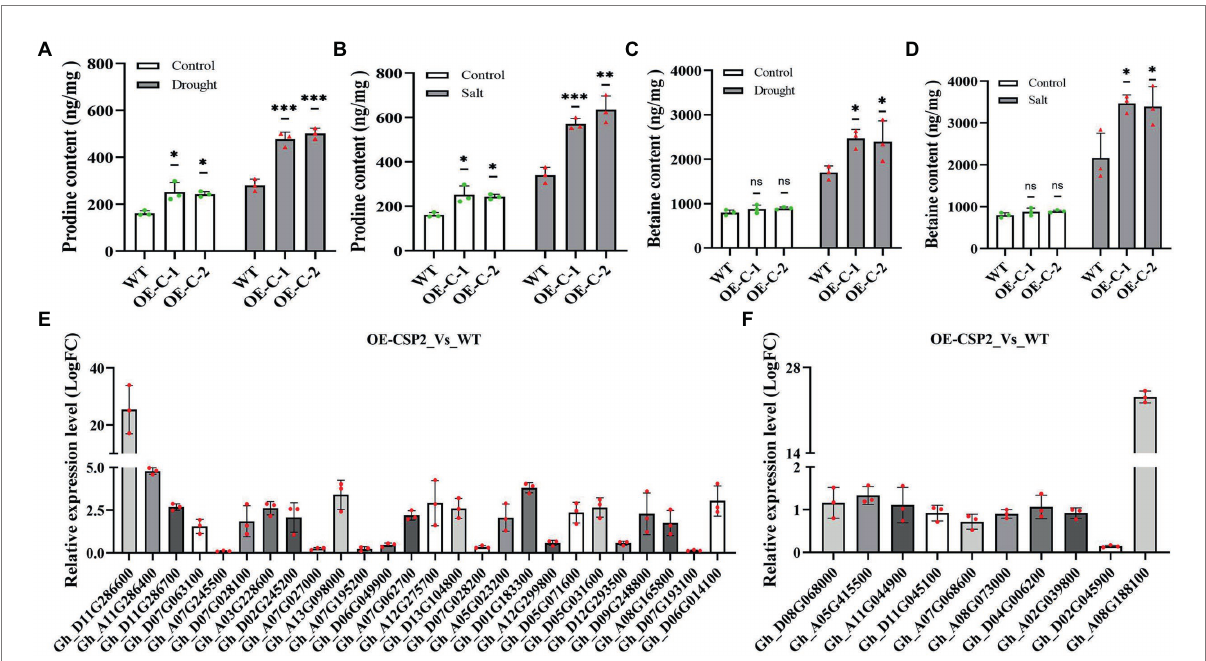
FIGURE 5 Analysis of proline and betaine contents and expression of related genes in transgenic cotton overexpressing DgCspC gene under drought or salt stress. (A) Proline content under drought stress; (B) proline content under salt stress; (C) betaine content under drought stress; (D) betaine content under salt stress; (E) expression of proline synthesis-related genes; (F) expression of betaine synthesis-related genes. (* p < 0.05, ** p < 0.01, *** p < 0.001 for comparisons between the transgenic lines and wild-type plants by Student’s t